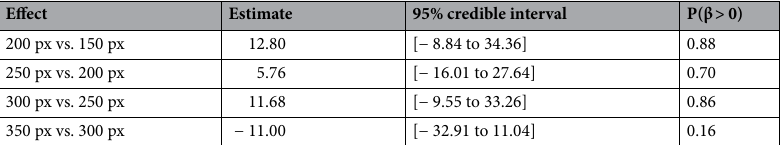
Table 2. Contrast estimates of the temporal error for consecutive spatial distances in Exp. 2 (interception). Positive values indicate that the response was longer in the consecutive